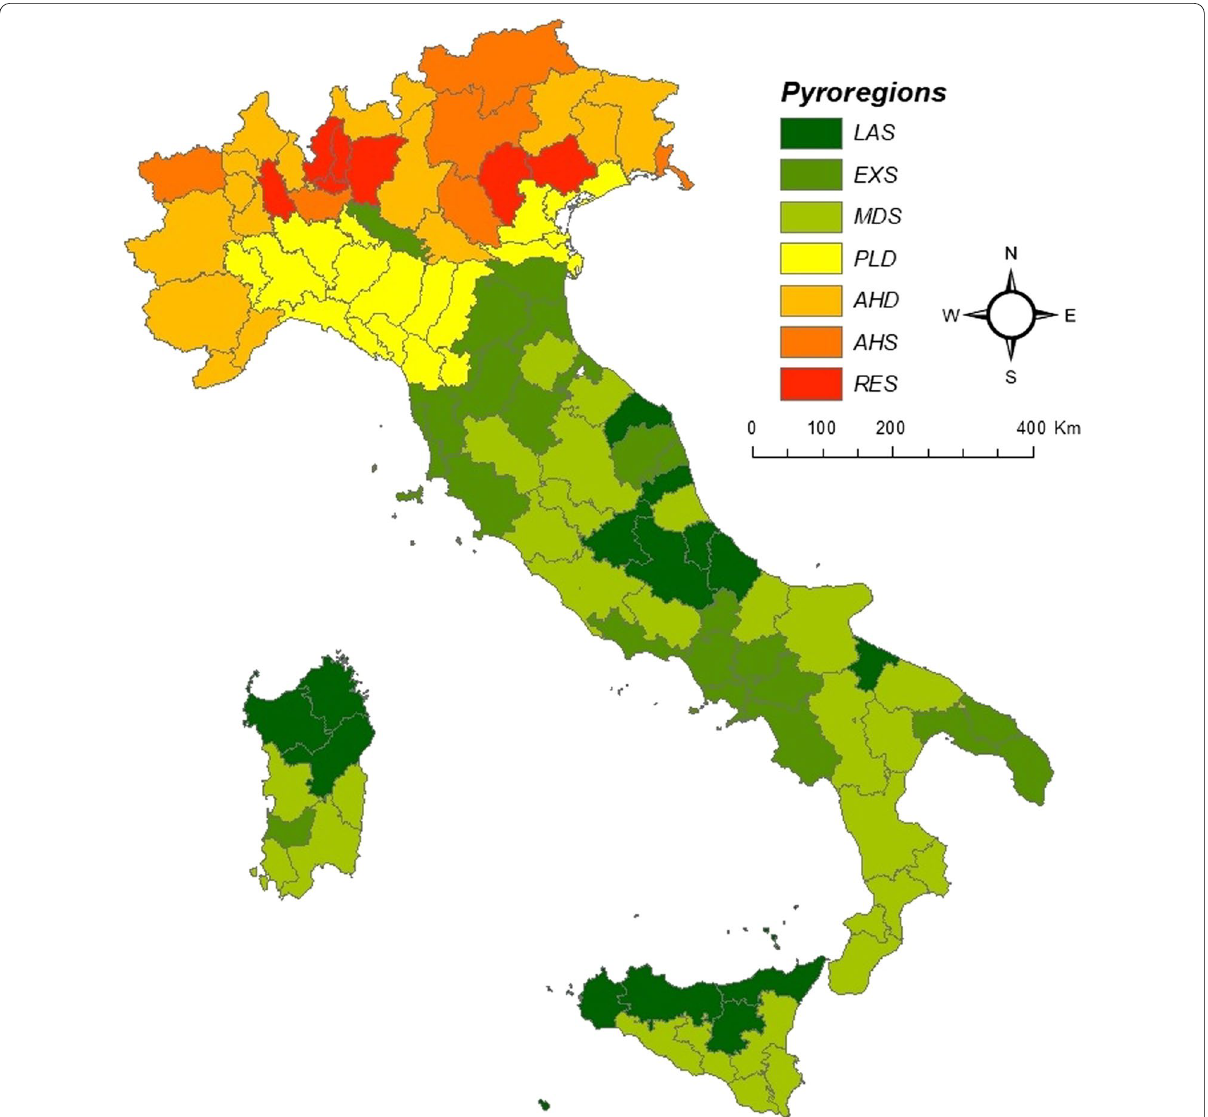
Fig. 3 Seven pyroregions uncovered by the Affinity Propagation analysis across the entire study area: Large summer wildfires (LAS) (14—NUTS3 provinces); Extreme stand-replacing summer wildfire (EXS) (24); Medium density summer wildfires (MDS) (28); Subalpine low density wildfires (PLD) (16); Alpine high density wildfires (AHD) (14); Alpine High Stand-replacing wildfires (AHS) (7); and Reduced stand-replacing wildfires (RES)